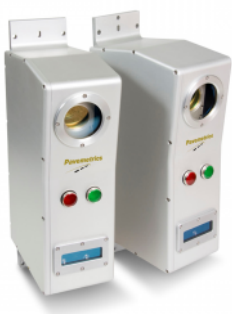
Figure 1. Pavemetric’s LCMS-2